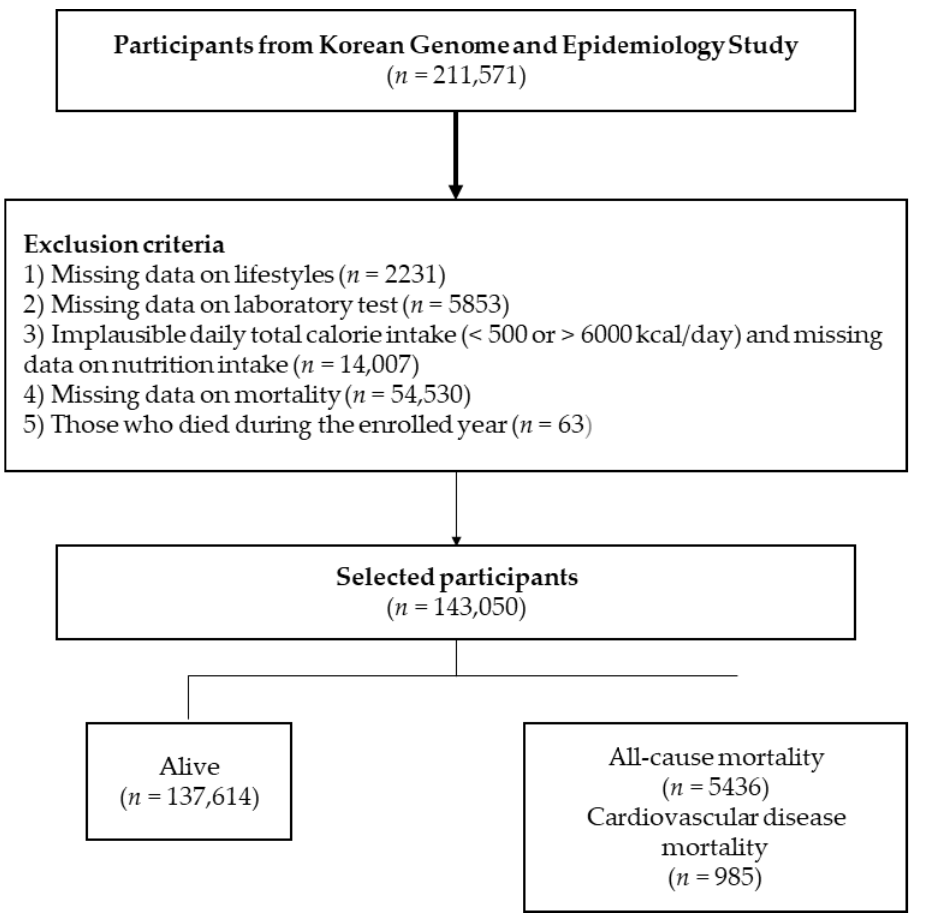
Figure 1. Selection process of study population.